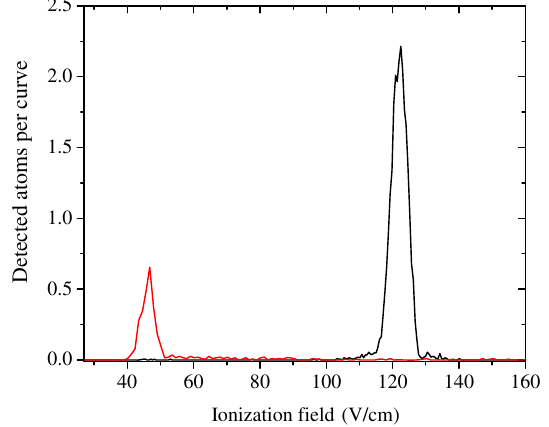
FIG. 10. Ionization signals. Number of detected atoms per sequence as function of the ionization field applied in the field- ionization detector for the laser-excited 52 m 2 state (red line) and for the 52 c state prepared by the adiabatic passage (black line). The difference of height of the two peaks results from the shorter lifetime of the 52 m 2 state. The residual peak in the black signal at the position of the red one probably results from Rydberg atoms spuriously prepared in the state m ¼ − 2 due to laser polarization imperfections.